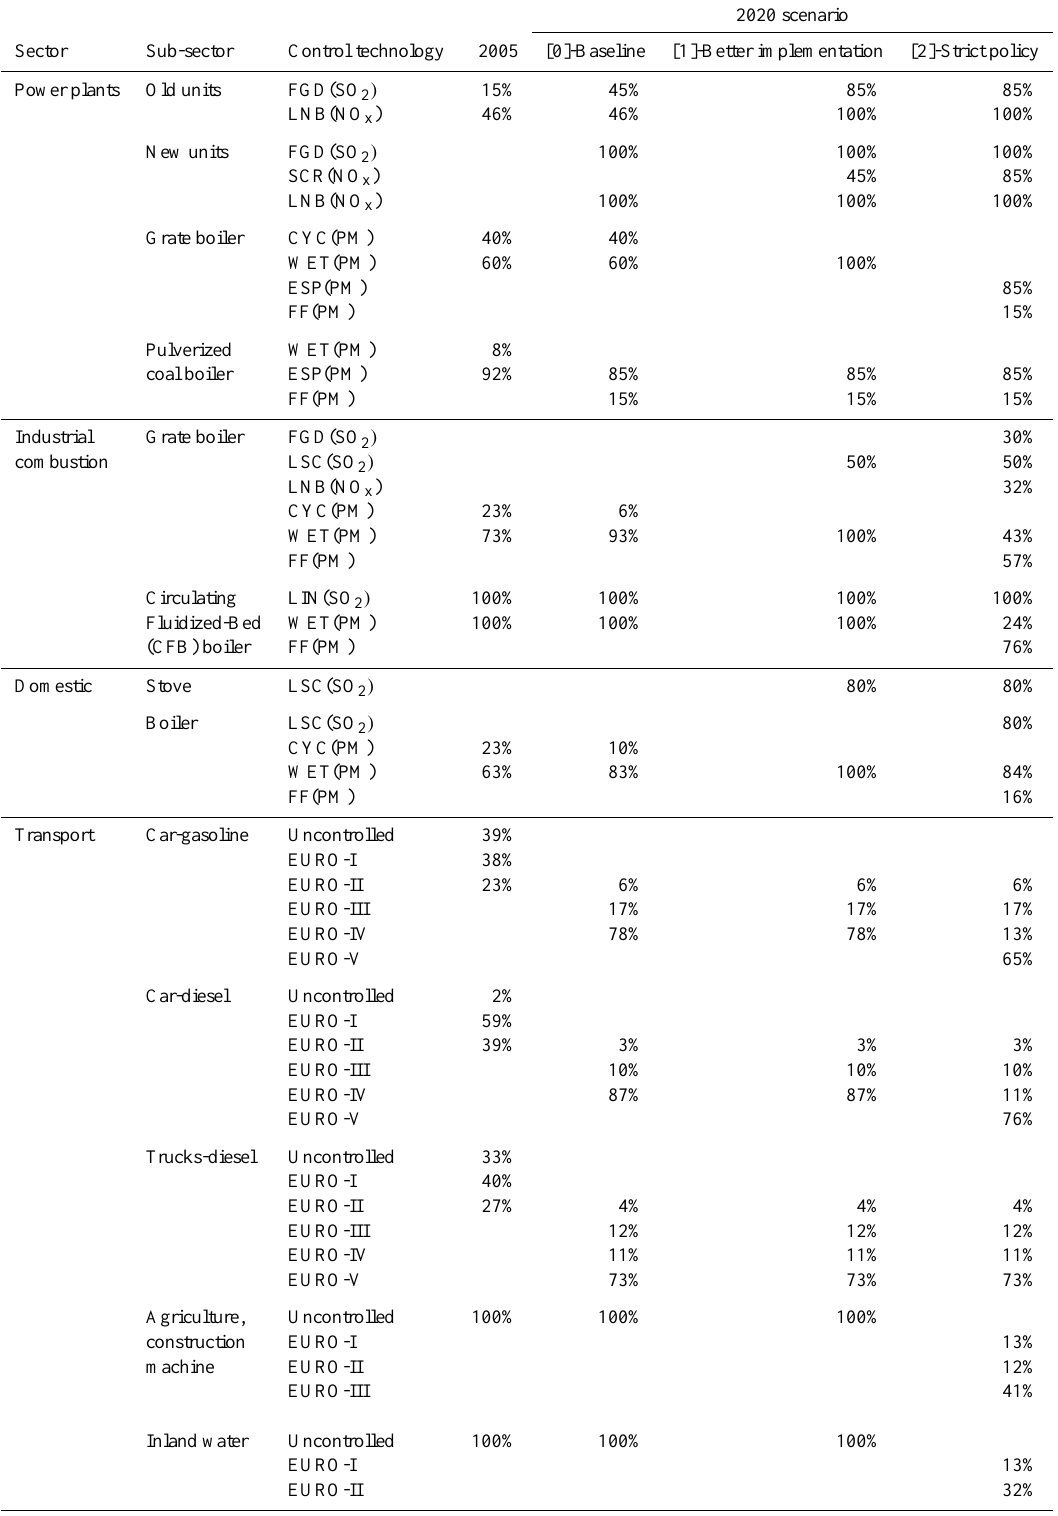
Table 3. Penetration of selected air pollution control measures assumed under three control